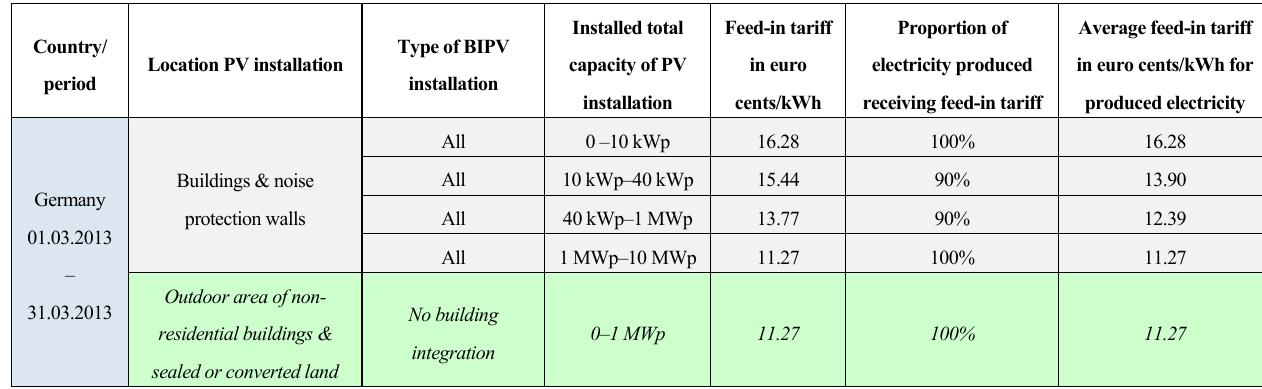
1. Overview of FiTs for photovoltaic generated electricity in